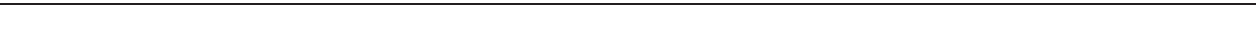
Fig. 4 The anillin – DIAPH3 interaction is required for the early stages of furrow organization and β -actin polymerization at the cleavage furrow. a HeLa cells in anaphase stained with DAPI (blue) to mark chromosomes and phalloidin (white) to mark F-actin and the cell cortex. b Comparative furrow ingression indices, a measure of the degree of ingression of the furrow on each side of the cell where 1 = symmetrical ingression, in the presence and absence of endogenous anillin, GFP-ANLN, and GFP-4xA. Inter-chromosomal mass distance 8 μ m + 0.1. Red bar = average, gray box = 25 – 75 percentile, and whiskers indicate data extremes. At least 100 cells were analyzed in each of three experimental repeats. * p = 0.013, ** p = 0.003, *** p = 0.0025, Student ’ s t test. c Comparative furrow instability indices, a measure of furrow position, where 1 = furrow ingression in the middle of the cell in the presence and absence of endogenous anillin, GFP-ANLN, and GFP-4xA. Red bar = average, gray box = 25 – 75 percentile, and whiskers indicate data extremes. At least 100 cells were analyzed in each of three experimental repeats. * p = 0.004, ** p = 0.003, *** p = 0.002, Student ’ s t test. d Comparative distribution of F-actin at the cell cortex in different conditions. At least 100 cells were analyzed in three experimental repeats. Error bars indicate ± s.e.m. * p = 0.006, ** p = 0.005, *** p = 0.002, Student ’ s t test. e HeLa cells in anaphase stained with antibodies speci fi cally recognizing β - and γ -actin during early anaphase. f Localization of β - and γ -actin in HeLa cells in the presence and absence of endogenous anillin, GFP-ANLN, and GFP-4xA. g Relative distribution of β - or γ -actin around the cell cortex. At least 100 cells were analyzed in each of three experimental repeats. Error bars indicate ± s.e.m. * p = 0.004, ** p = 0.002, Student ’ s t test. All scale bars are 10 μ